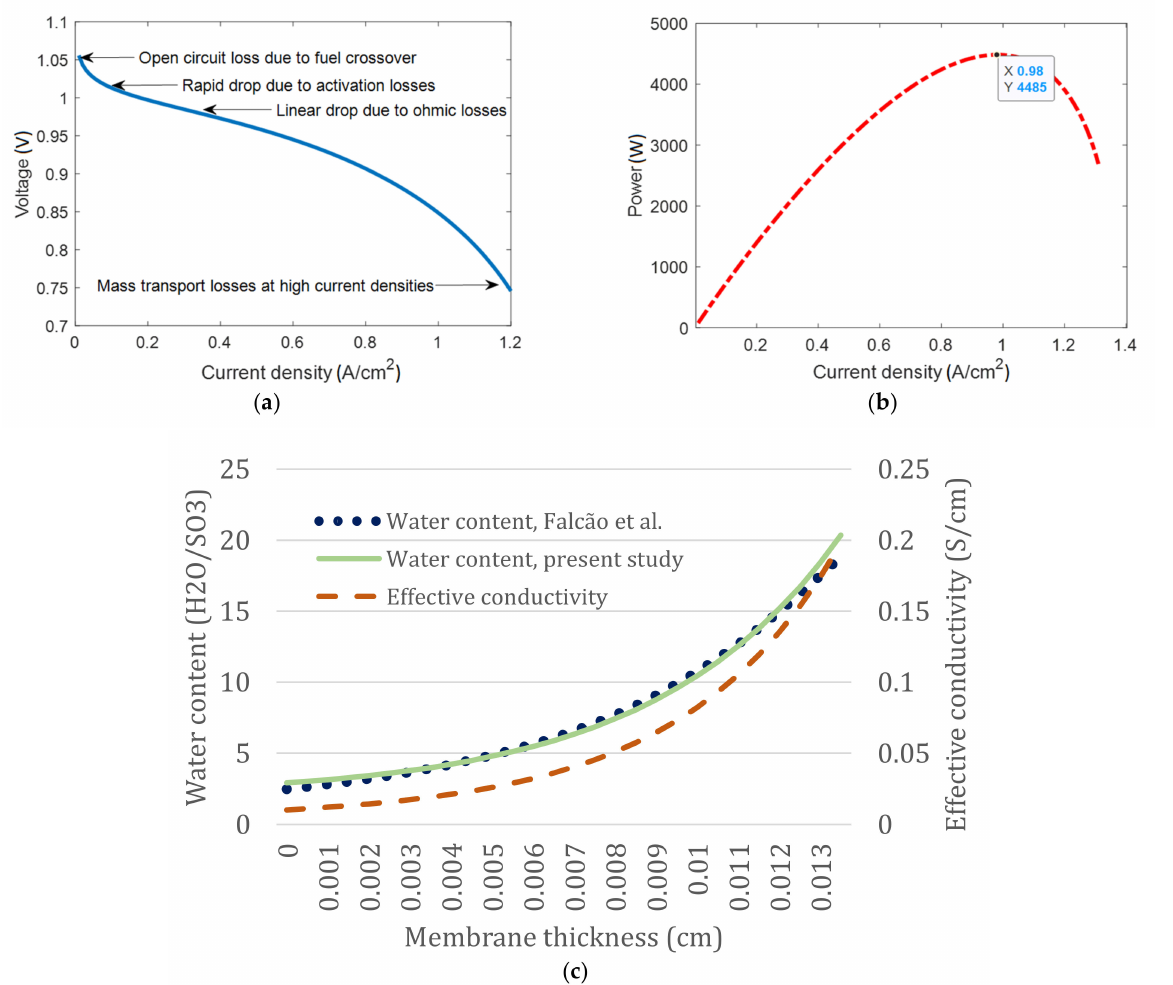
Figure 13. Performance characteristics and membrane properties simulated with the input param- eters in Table 1 considering fuel utilization of 78% and 800 mA/cm 2 ; ( a ) I-V, ( b ) P-I, ( c ) simulated dependence of the water content and effective conductivity on the thickness of the